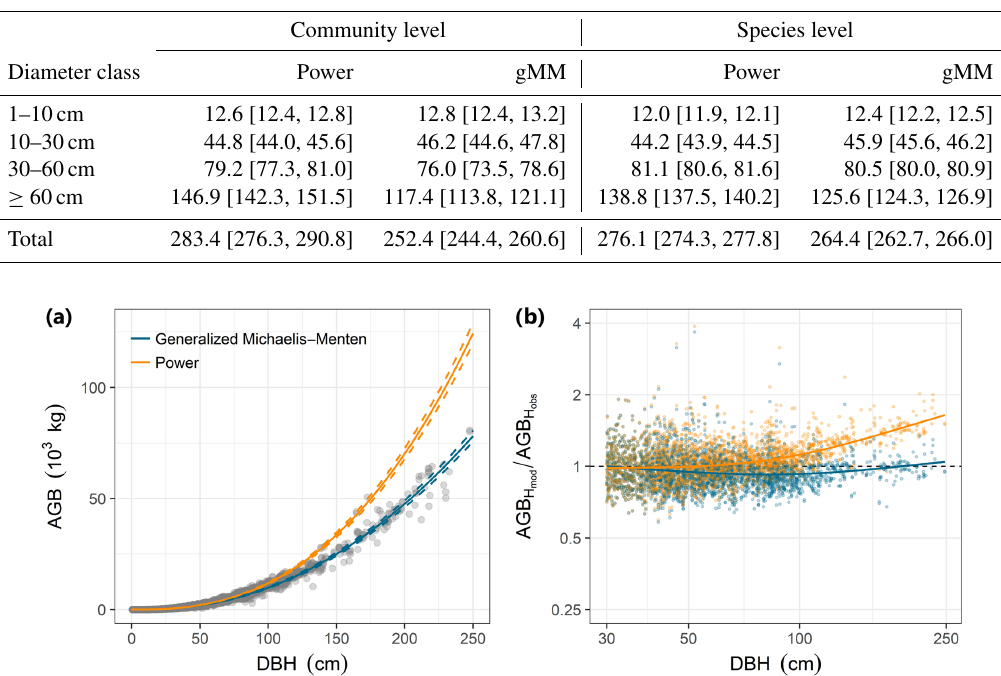
Figure 4. Comparison of estimates of individual tree aboveground biomass (AGB, kilograms of dry matter) as a function of trunk diameter (DBH) for the power function (orange) and the generalized Michaelis–Menten (blue) tree height allometric models. (a) AGB estimates based on observed tree heights (grey points) were compared with those based on height predicted from community-level power function (orange lines) or generalized Michaelis–Menten (blue lines) models. The lines are predictions from the allometric models and are based on simulations of the posterior distribution (solid and dashed lines correspond to the median and 90% posterior central interval, respectively) of the community-level, across-species relationships. (b) Relative error for estimates of AGB based on model predictions of tree height (AGB Hmod ) compared with estimates derived from height observations (AGB Hobs ) , for trees with DBH>30cm (the full range is shown in Fig. S3). Modeled tree heights were from community-level models fitted with either the power function (orange dots) or generalized Michaelis–Menten function (blue dots). The lines are LOESS smoothers that illustrate the overall departures of each model from perfect prediction (i.e., AGB Hmod / AGB Hobs ratio equal to unity) as a function of DBH. All AGB estimates in (a) and (b) were based on biomass allometry (Eq. 6; Chave et al., 2014) and used the average value of wood density across species ( ρ = 0 . 5304gcm − 3 ; data from Wright et al., 2010) to highlight variation related to the height